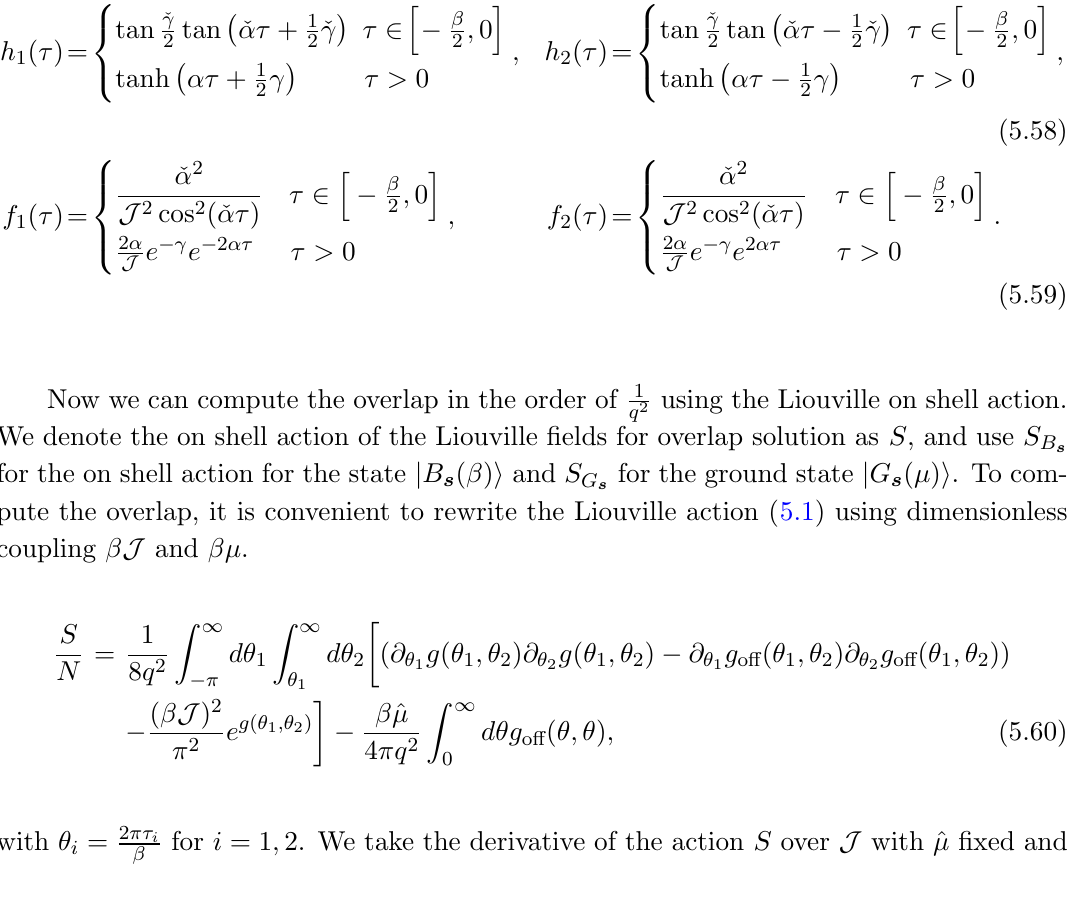
sin (cid:20) (cid:13) , (cid:11) = sinh (cid:13) and the matching condition e (cid:0) (cid:13) = cos (cid:20) (cid:13) . J J